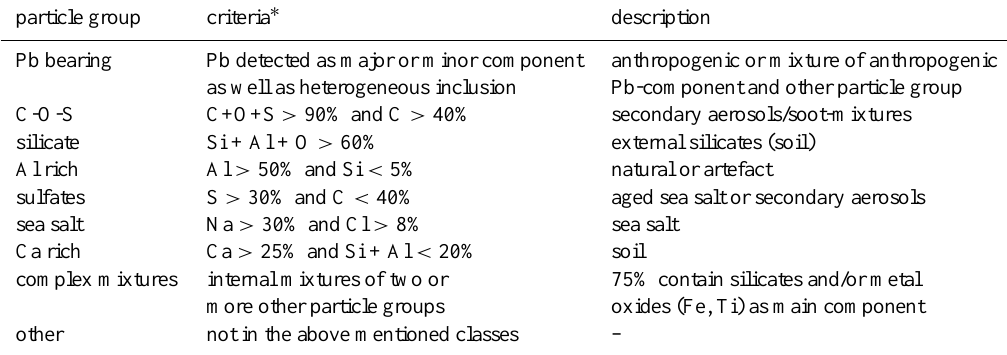
Table 2. Criteria for classification of particle